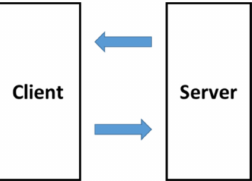
Figure 10. Remote procedure invocation integration style.